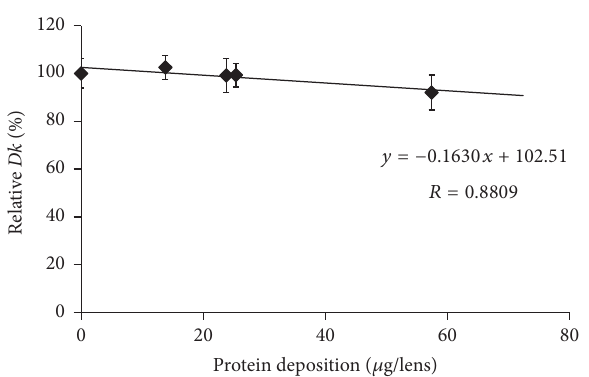
Figure 4: Relationship between relative Dk and amount of protein deposition on lotrafilcon A lens.